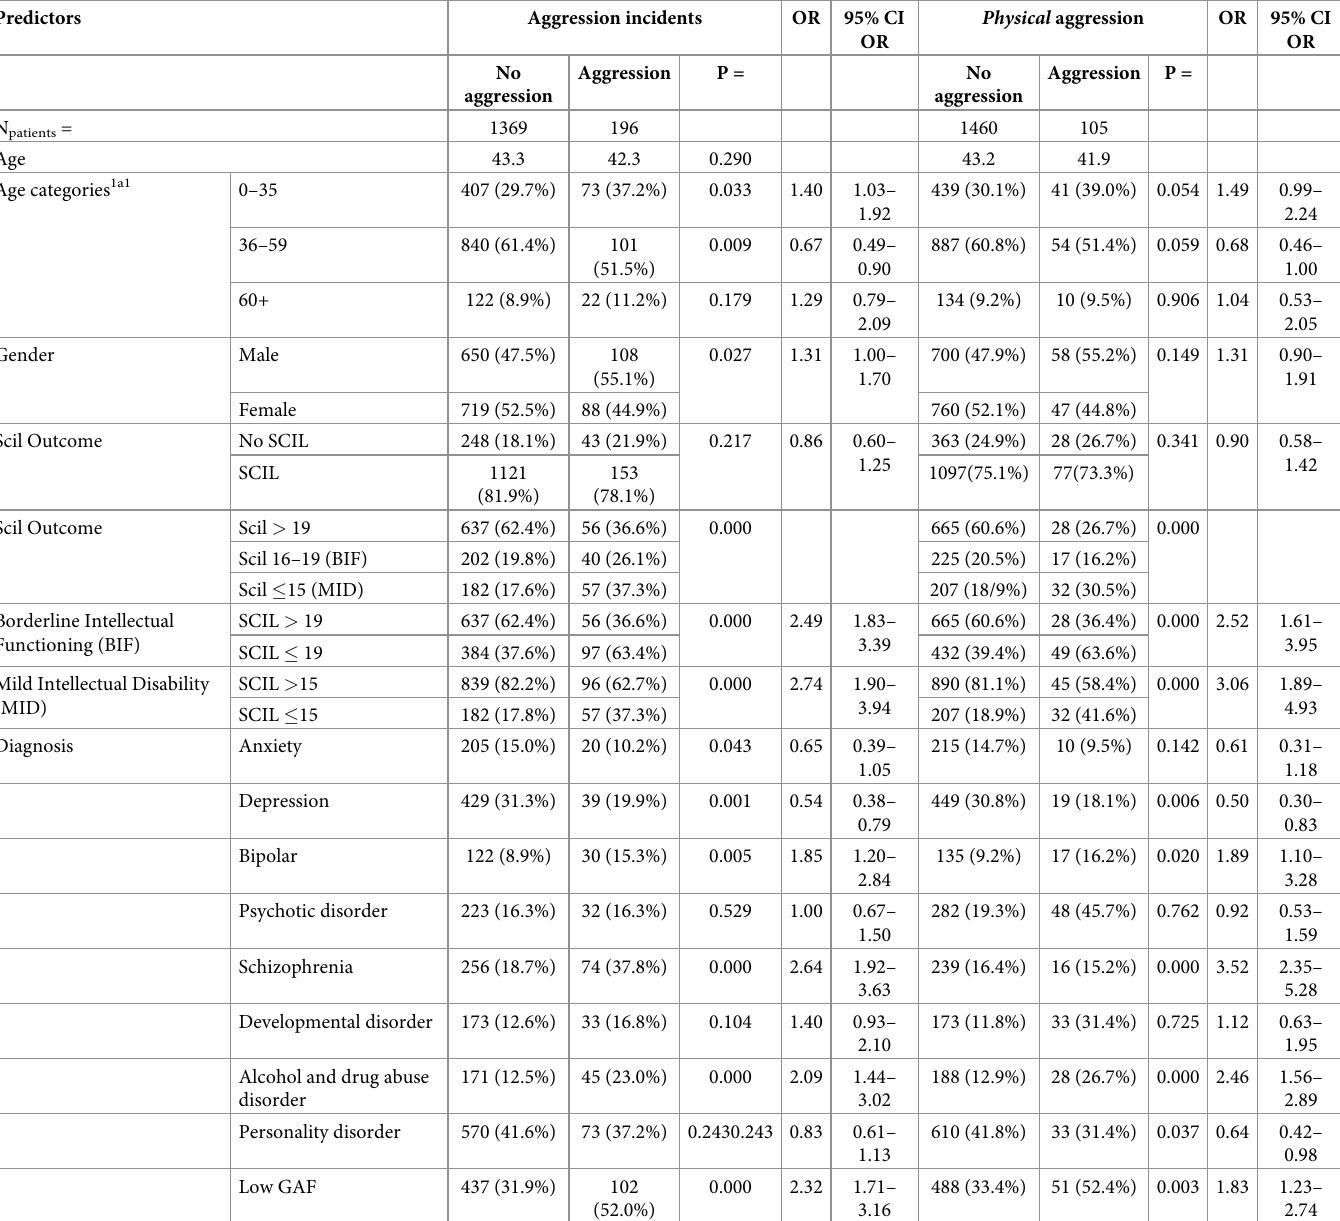
Table 2. Association between aggression BIF, MID and patient